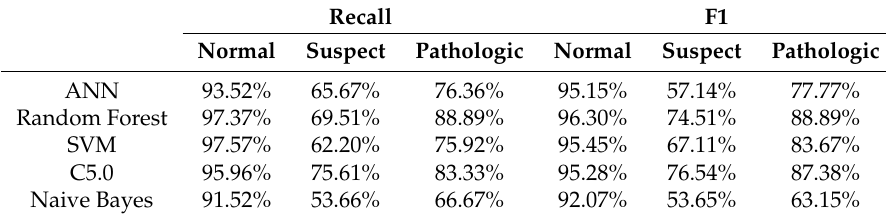
Table 6. Evaluation Criteria for CTG data for prediction before genetic algorithm.